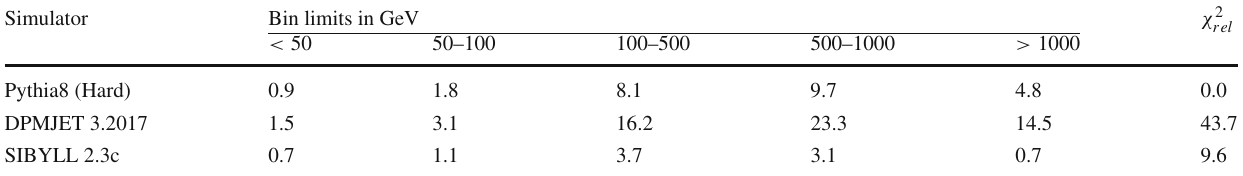
Table 4 The number of τ events within the SM at FASER ν using the prediction of three different simulators [11]. The relative χ 2 minimized over normalization uncertainty of 15% is shown in the last column, assuming Pythia8 (Hard) as the true model Simulator Bin limits in GeV